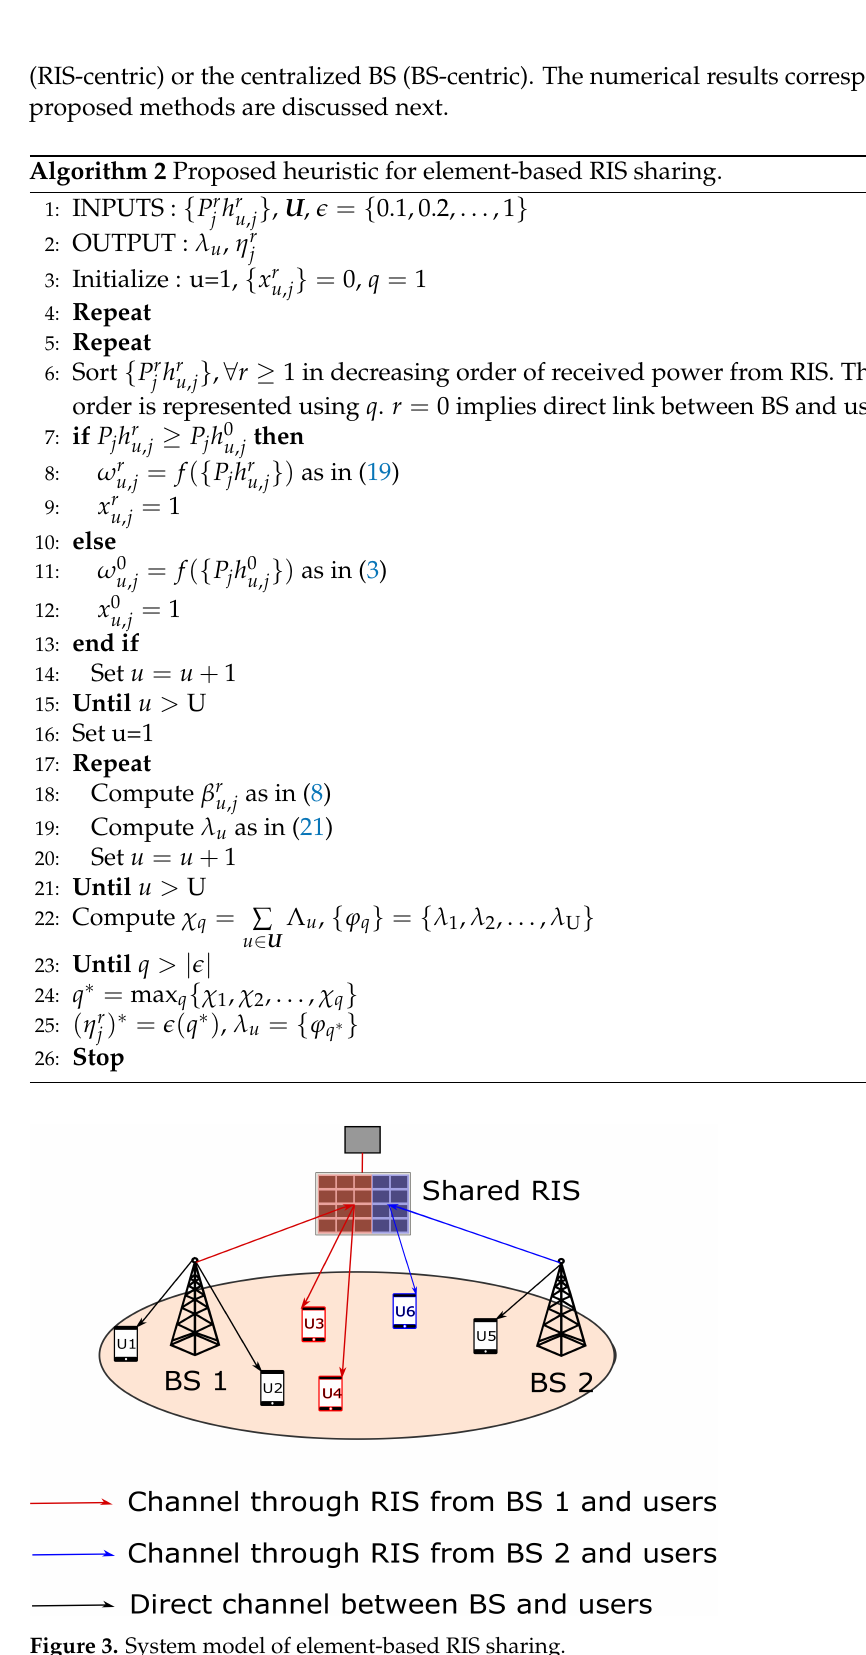
Figure 3. System model of element-based RIS